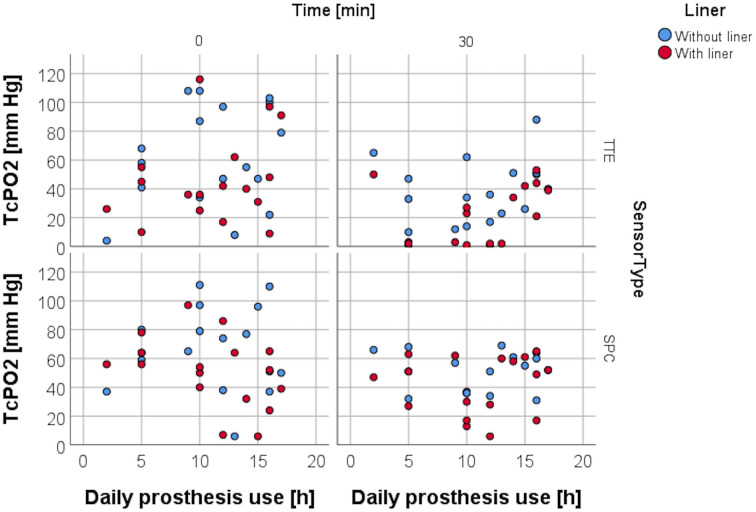
TcPO2 levels and daily prosthetic use.Scattergram depicting distribution of TcPO2 levels with and without liner wear depending on daily prosthetic use.